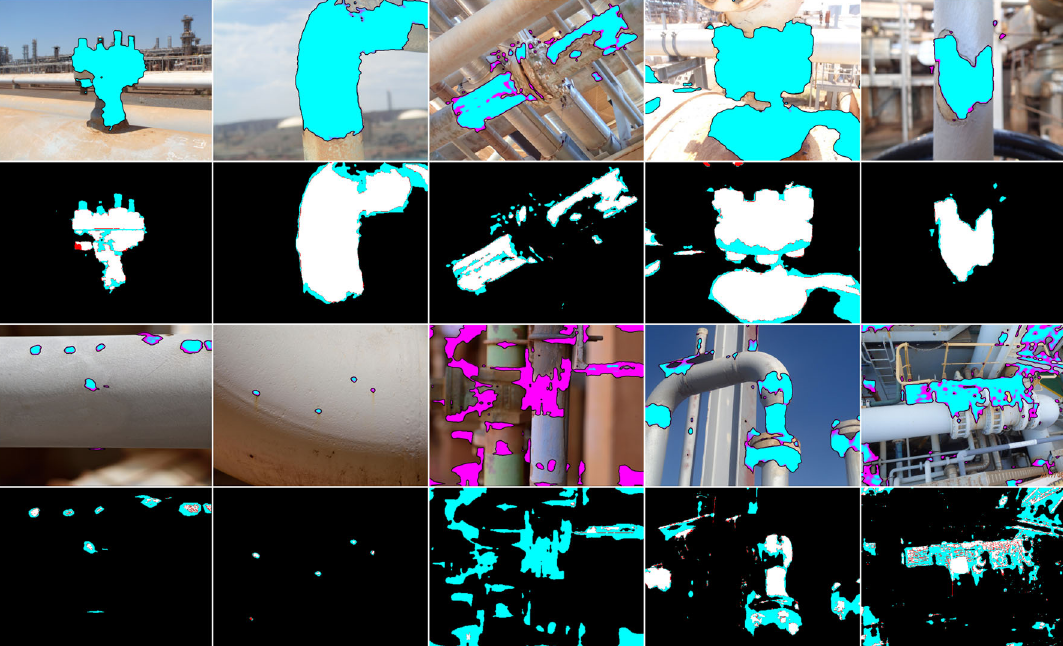
Fig. 6 Variational model detection and accuracy maps. The corrosion detection output ( fi rst and third row) and accuracy maps (second and fourth row) from the variational model of the input and ground truth label maps shown in Fig. 5. Detection colour determined by output layer con fi dence, cyan is